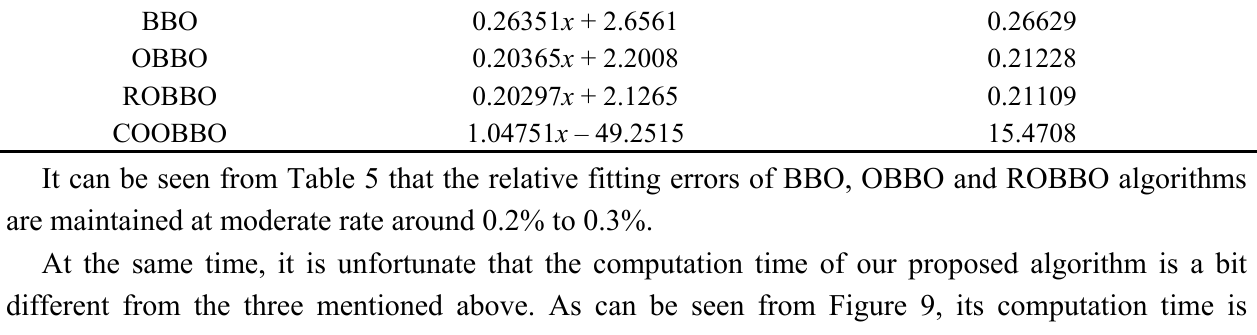
Table 5. Fitting results of BBO, OBBO, ROBBO and COOBBO algorithms.